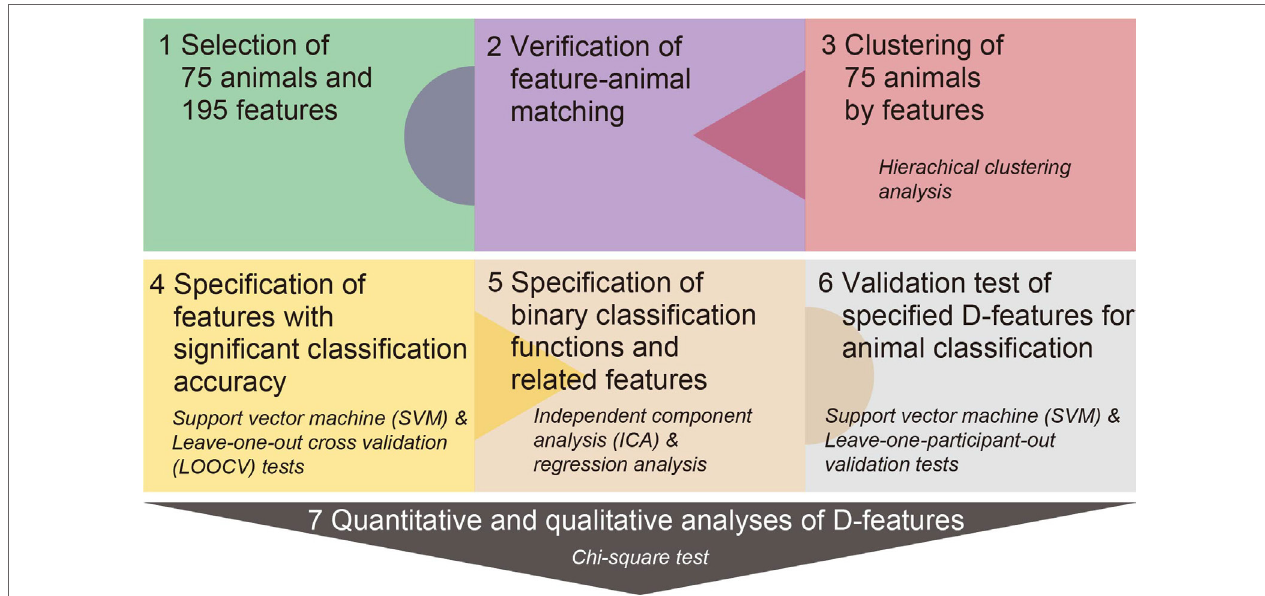
FigUre 1 | Experimental procedure. The 75 animals across the three classes and 195 features were selected from previous studies (Procedure 1). Participants judged whether animals possessed the given feature via a ternary responses (“Yes,” “No,” or “neither Yes nor No”) (Procedure 2). The 75 animals were clustered by a hierarchical clustering analysis using similarities (Euclidean distances) of Yes/No responses from the feature-animal matching verification test (Procedure 3). Classification accuracy for each feature was calculated using support vector machine (SVM) and leave-one-out cross-validation tests (Procedure 4). Dominant response functions with a sigmoid shape were estimated for each classification level through an independent component analysis and regression analyses of response patterns for features via the ICs (Procedure 5). Validity of a classification model with specified distinguishing/deterministic (D-) features was tested by SVM following the leave-one-participant-out method (Procedure 6). Quantitative and qualitative properties of specified D-features were examined with χ 2 tests (Procedure 7). Quantitative analyses compared the numbers of D-features among super-ordinate and sub-ordinate classification levels. Qualitative analyses compared the proportions of biological and cultural/affective features between the two classification